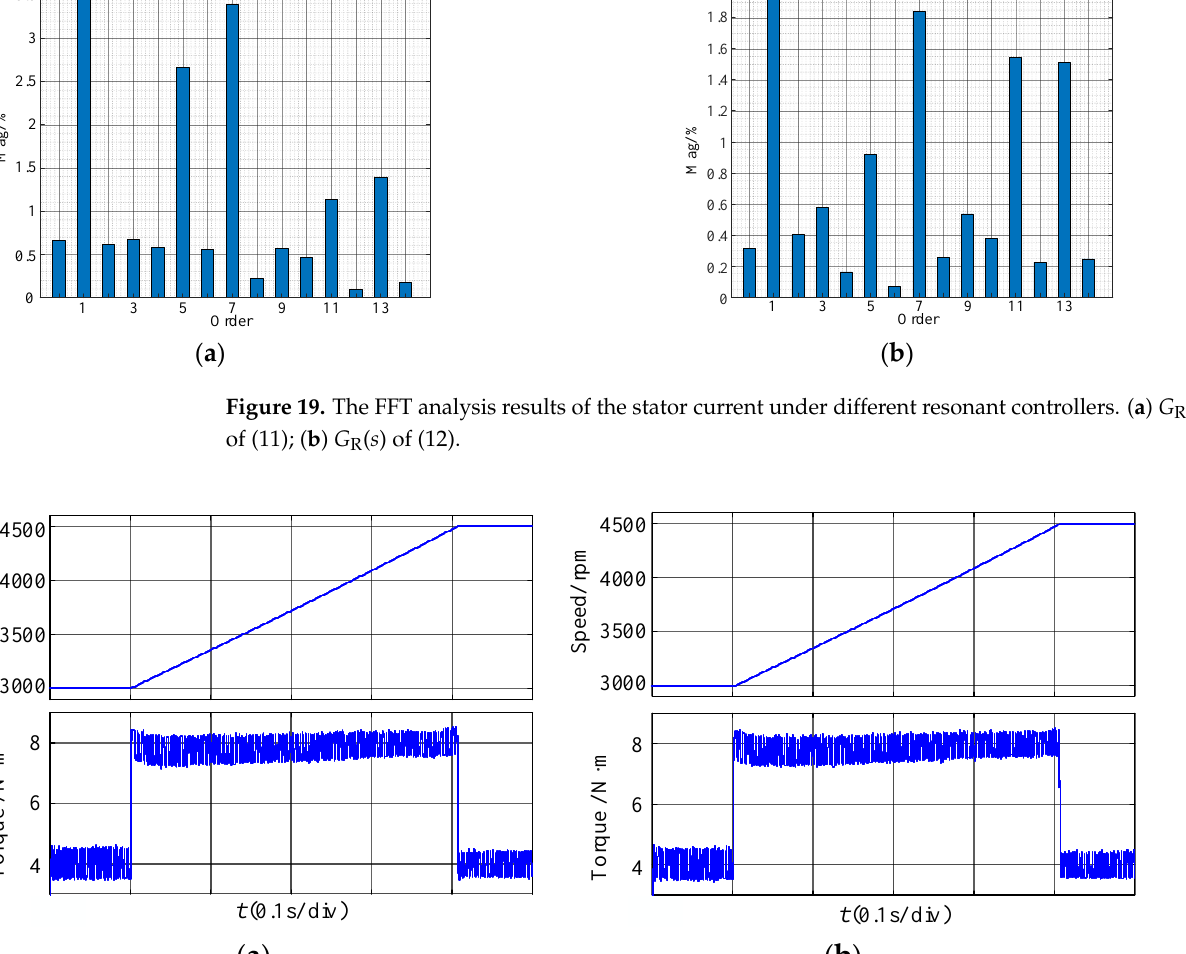
G R ( s ) of (11); ( b ) G R ( s ) of (12).